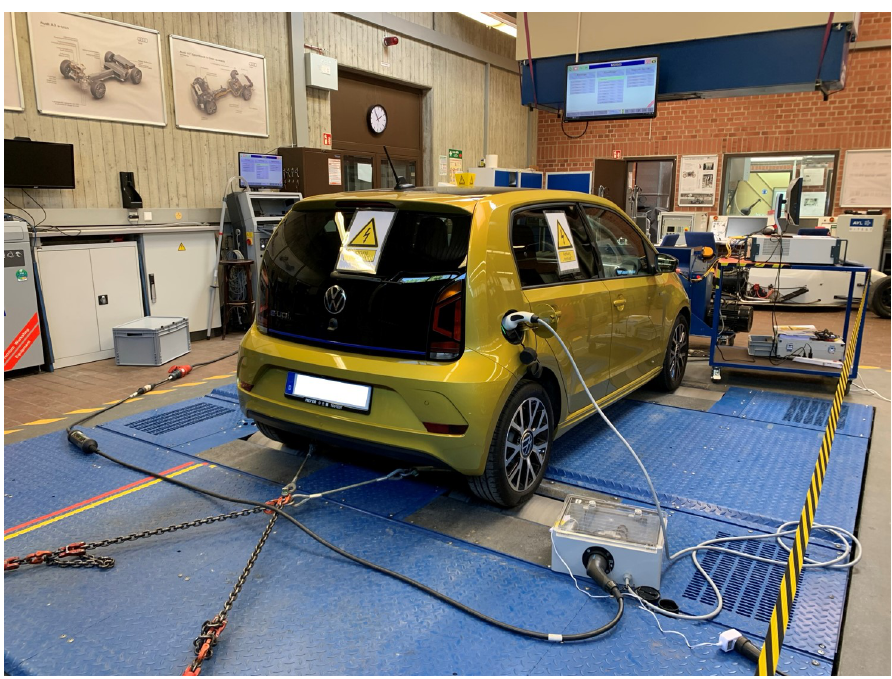
Figure 6. VW e-Up on the test bench connected with the energy analyzer and the